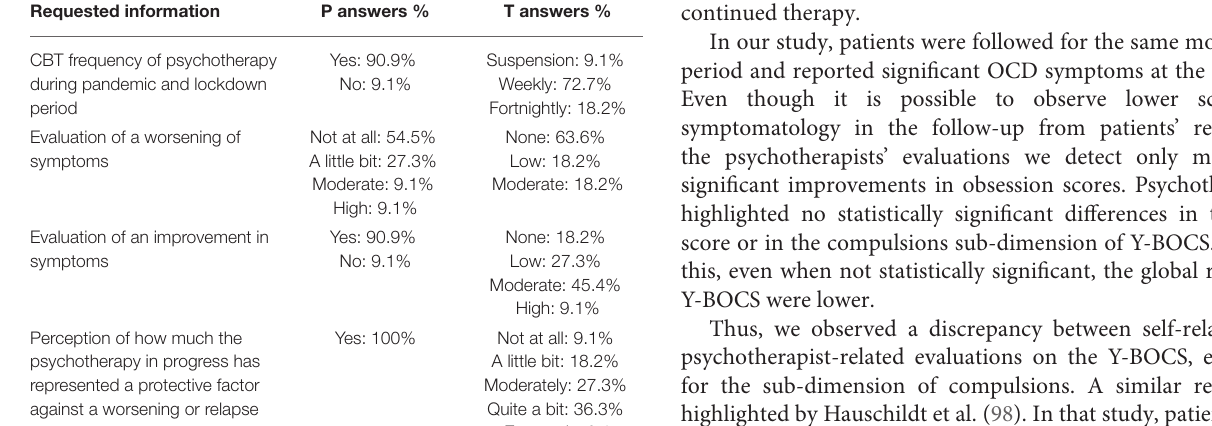
TABLE 4 | Descriptive data: responses to the qualitative questionnaire administered to OCD patients and their psychotherapists. Requested information P answers % T answers